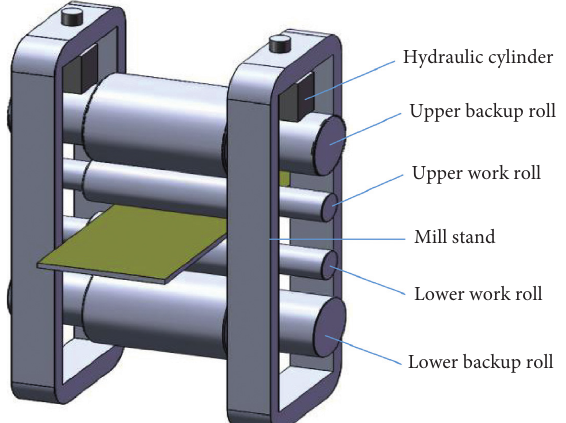
Figure 1: Structure of 1780 hot rolling